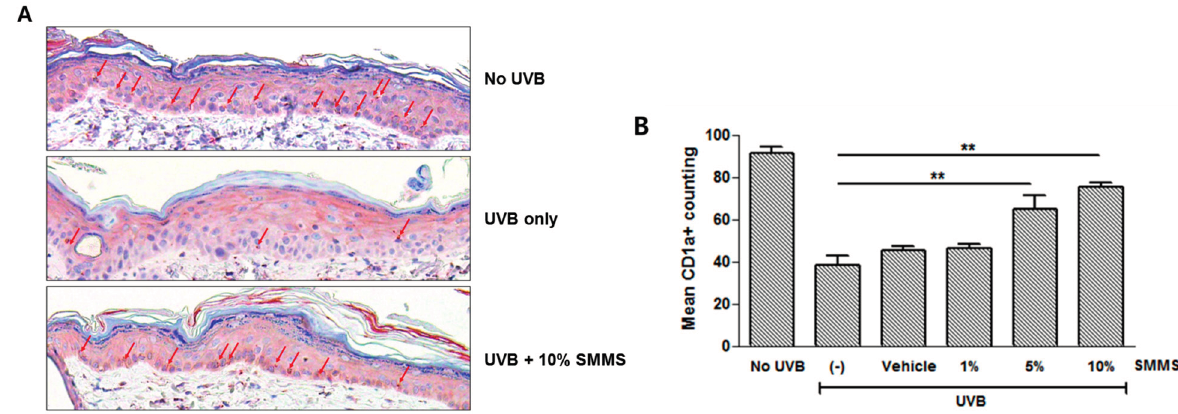
Figure 4. Immunohistochemical staining of cluster of differentiation 1a (CD1a) for epidermal Langerhans cells (LCs). ( A ) The depletion of epidermal LCs was measured via a CD1a staining 72 h after UVB irradiation (2× MED). Arrow indicates CD1a + cells. Scale bars = 100 µm; ( B ) Application of 5% and 10% SMMS significantly reduced the UVB-induced LC depletion. (-) stands for UVB-irradiated control. All values are presented as a mean ± STD ( n = 3). ** p <